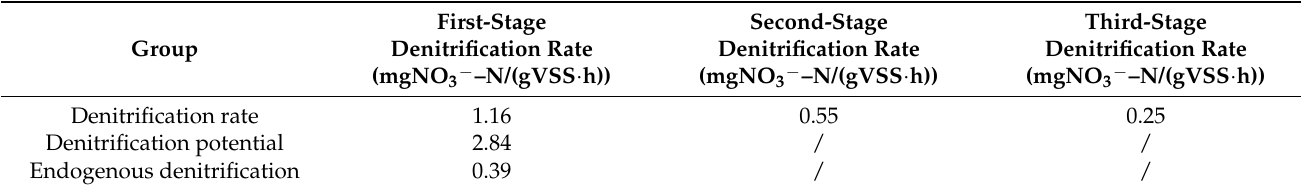
Table 1. The denitrification rate of activated sludge in the CAST